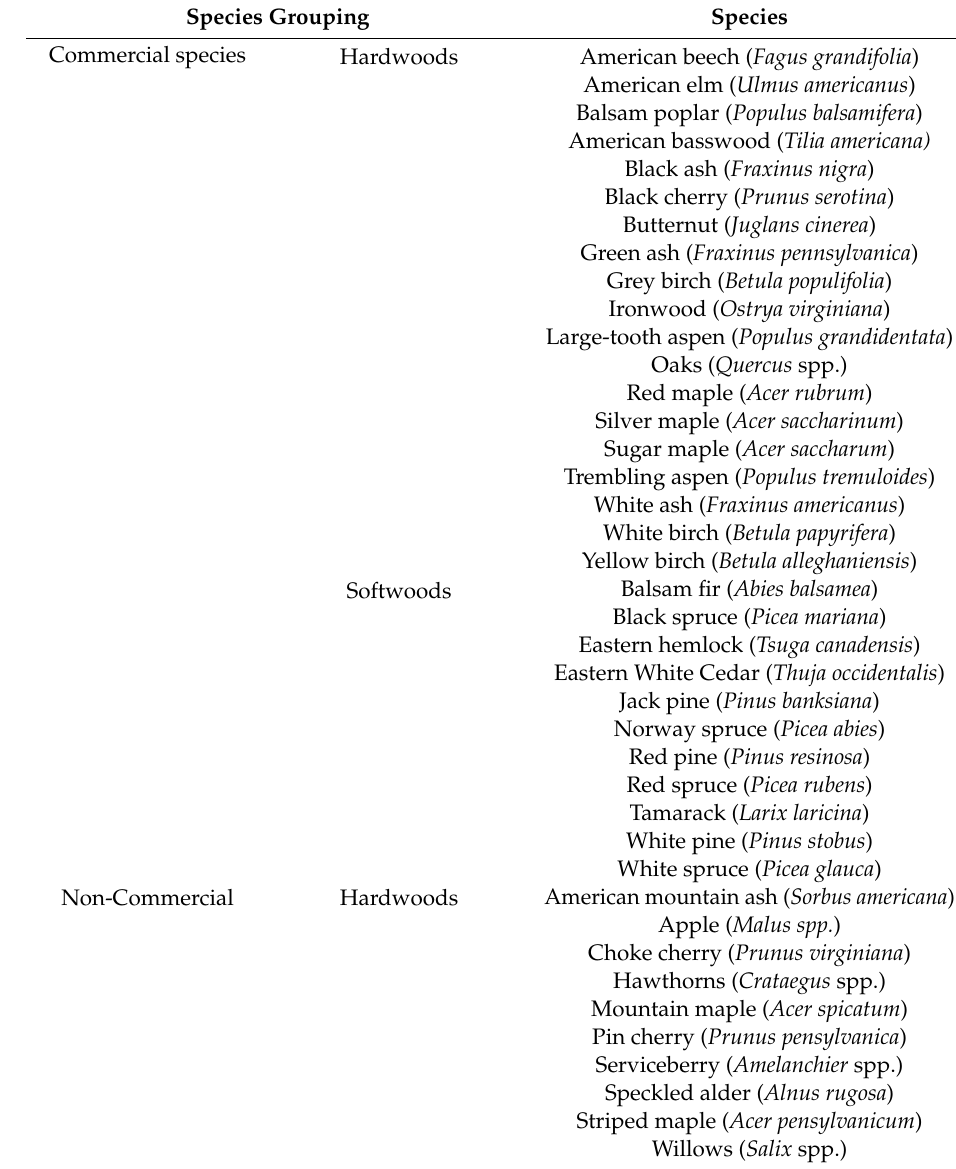
Table 2. Species groupings for which sapling density was